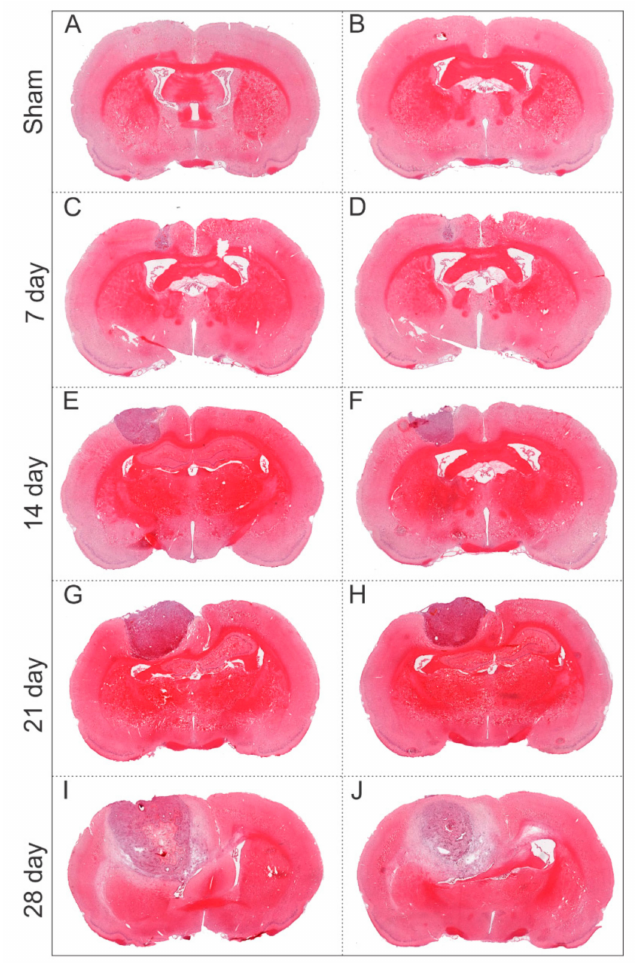
Figure 6. Evaluation of tumor growth by histology using H&E over 28 days after C6 cells tumor induction. ( A , B ) Sham group, brain without tumor induction, only medium injection. ( C , D ) Histological sections of tumoral tissue after seven days of tumor induction, ( E , F ) after 14 days, ( G , H ) after 21 days, and ( I , J ) after 28